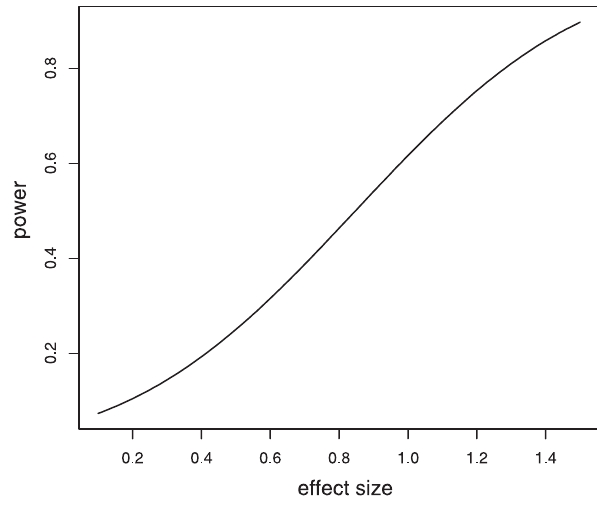
Figure 2. Power curve for comparisons of mismatch rates between LCL and PBMC pairs and duplicate pairs. Relationship between effect size, in units of (pooled) standard deviation, and statistical power, for a Mann-Whitney U test (one-sided, unequal sample sizes) with group samples sizes of 19 and 4. There is power of 0.62 to detect a difference in means of one standard deviation between LCL and PBMC pairs and duplicate pairs, equal to , 90 SNPs out of . 300,000 compared.